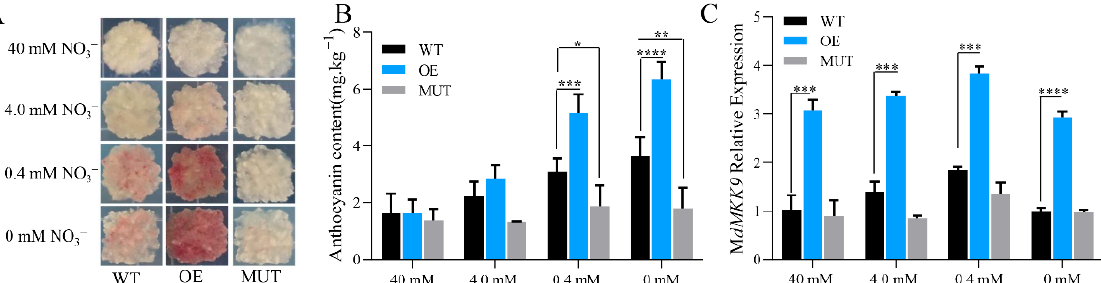
NO 3 − , the gene expression levels of OE lines were slightly higher than those of WT lines Figure 7. The phenotype, anthocyanin content, and MdMKK9 expression levels of calli from wild- and significantly higher than those of MUT lines. type (WT) ‘Orin’ plants, transformed CRISPR/Cas9- MdMKK9 (MUT) lines, and transformed pRI101- MdMKK9 (OE) lines grown in mediums with different nitrogen concentrations. ( A ) Phenotypes of the calli. ( B ) Anthocyanin content. ( C ) Relative expression levels of MdMKK9 . The relative level of MdMKK9 in 40 mM NO 3 − treated WT calli was set to 1. The bars represent means ± SD ( n = 3). As- terisks indicate statistically significant differences (* p < 0.05; ** p < 0.01; *** p < 0.001; **** p < 0.0001). In this case, qRT-PCR was used to determine the relative expression levels of antho- cyanin synthesis-related structural genes ( MdPAL , MdCHS , MdCHI , MdF3H , MdDFR , MdANS , MdANR and MdUFGT ) (Figure 8A) and regulatory genes ( MdMYB10 , MdbHLH3 and MdWD40 ) (Figure 8B) in the calli of different lines. In growth mediums with 40, 4, 0.4 and 0 mM NO 3 − , there were progressively increased in the expression levels of all antho- cyanin synthesis-related genes in WT and OE calli. The expression levels of those genes Figure 7. The phenotype, anthocyanin content, and MdMKK9 expression levels of calli from in MUT calli showed little difference across growth mediums with different nitrogen con- wild-type (WT) ‘Orin’ plants, transformed CRISPR/Cas9- MdMKK9 (MUT) lines, and transformed centrations. In the culture medium with 0.4 mM NO 3 − , the expression level of each gene pRI101- MdMKK9 (OE) lines grown in mediums with different nitrogen concentrations. ( A ) Pheno- increased significantly in the OE and WT lines and remained high even with decreasing types of the calli. ( B ) Anthocyanin content. ( C ) Relative expression levels of MdMKK9 . The relative nitrogen concentrations of the medium. In culture mediums with 0.4 mM and 0 mM NO 3 − , level of MdMKK9 in 40 mM NO 3 − treated WT calli was set to 1. The bars represent means ± SD the gene expression levels of OE lines were slightly higher than those of WT lines and ( n = 3). Asterisks indicate statistically significant differences (* p < 0.05; ** p < 0.01; *** p < 0.001; significantly higher than those of MUT lines. **** p < 0.0001).